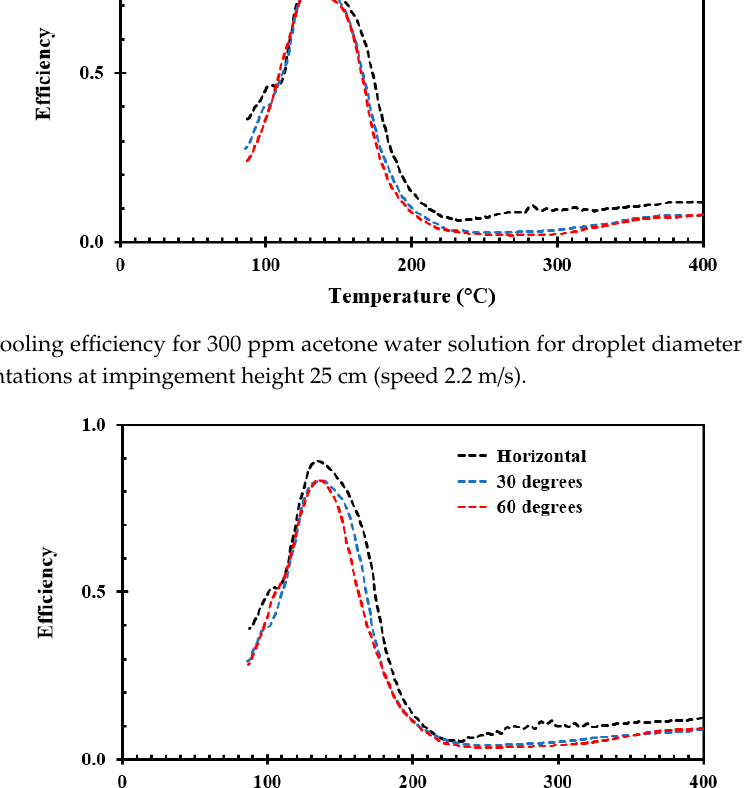
Figure 17. Cooling efficiency for 35 g/kg NaCl water solution for droplet diameter 2.5 mm, and various orientations at impingement height 25 cm (speed 2.2 m/s). 4.2.3. Effect of Impact Speed on Cooling Efficiency The results obtained for variation in impinging heights are presented in Figures 18, 19 and 20 for 300 ppm and 700 ppm acetone solutions and 35 g/kg NaCl solution, respectively. Figure 18. Cooling efficiency for 300 ppm acetone solution for droplet diameter 2.5 mm, horizontal orientation. Impingement heights and speeds are given in the figure label.